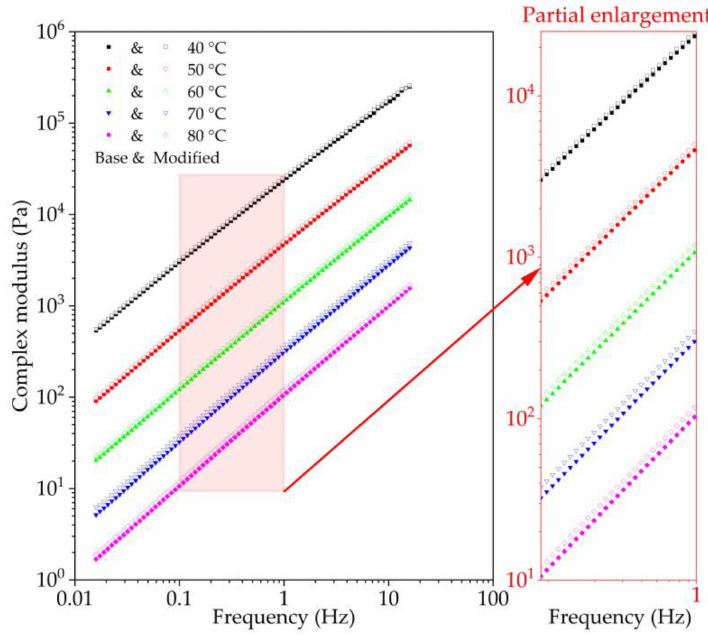
Figure 5. Complex modulus results versus frequencies and temperatures for base bitumen and nano-TiO 2 /CaCO 3 modified bitumen.